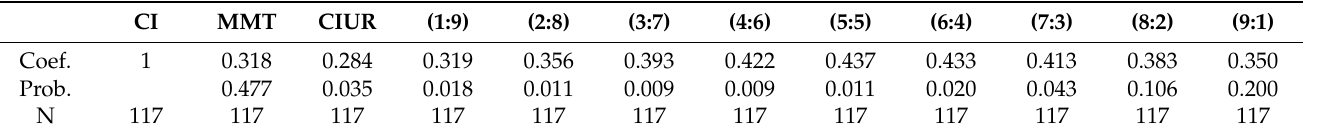
Table 2. Correlation Analysis to Verify the Optimal Weights of Momentum and Crisis Index Upside Risk.